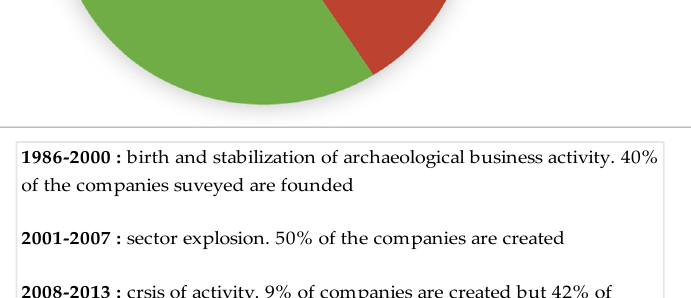
Figure 3. Percentage of Spanish archaeology companies that started their activity by period and data analysis. Modified from [30].